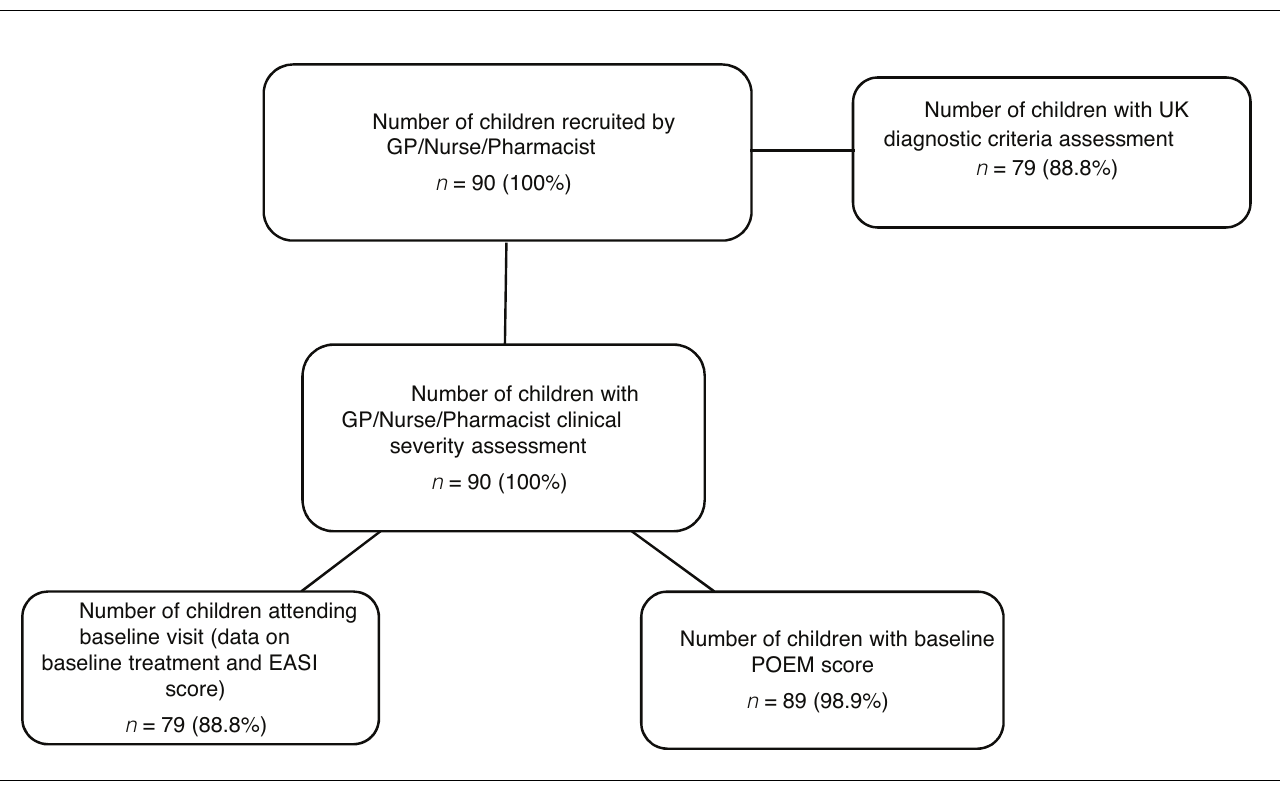
Figure 1. Participant